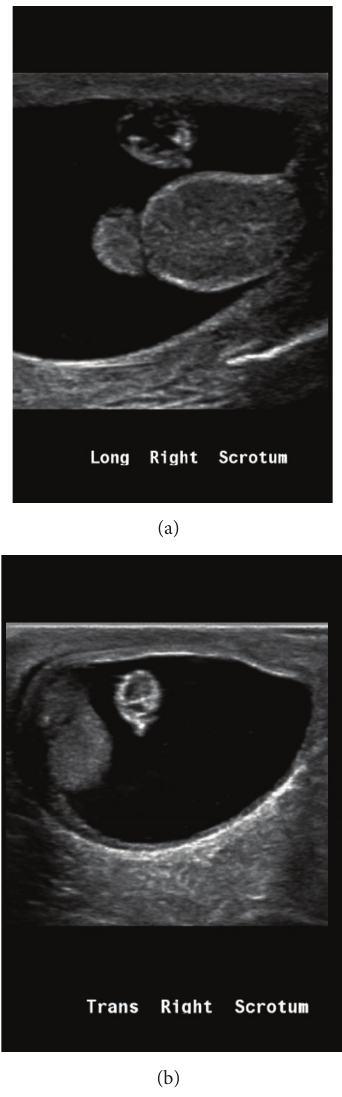
Figure 3: (a) Initial scrotal ultrasound showing large avascular extratesticular mass measuring 0.5 × 0.55 × 0.57 cm. (b) Six-week follow-upscrotalultrasoundshowsdecreaseinsizeofextratesticular mass measuring 0.39 × 0.37 × 0.44